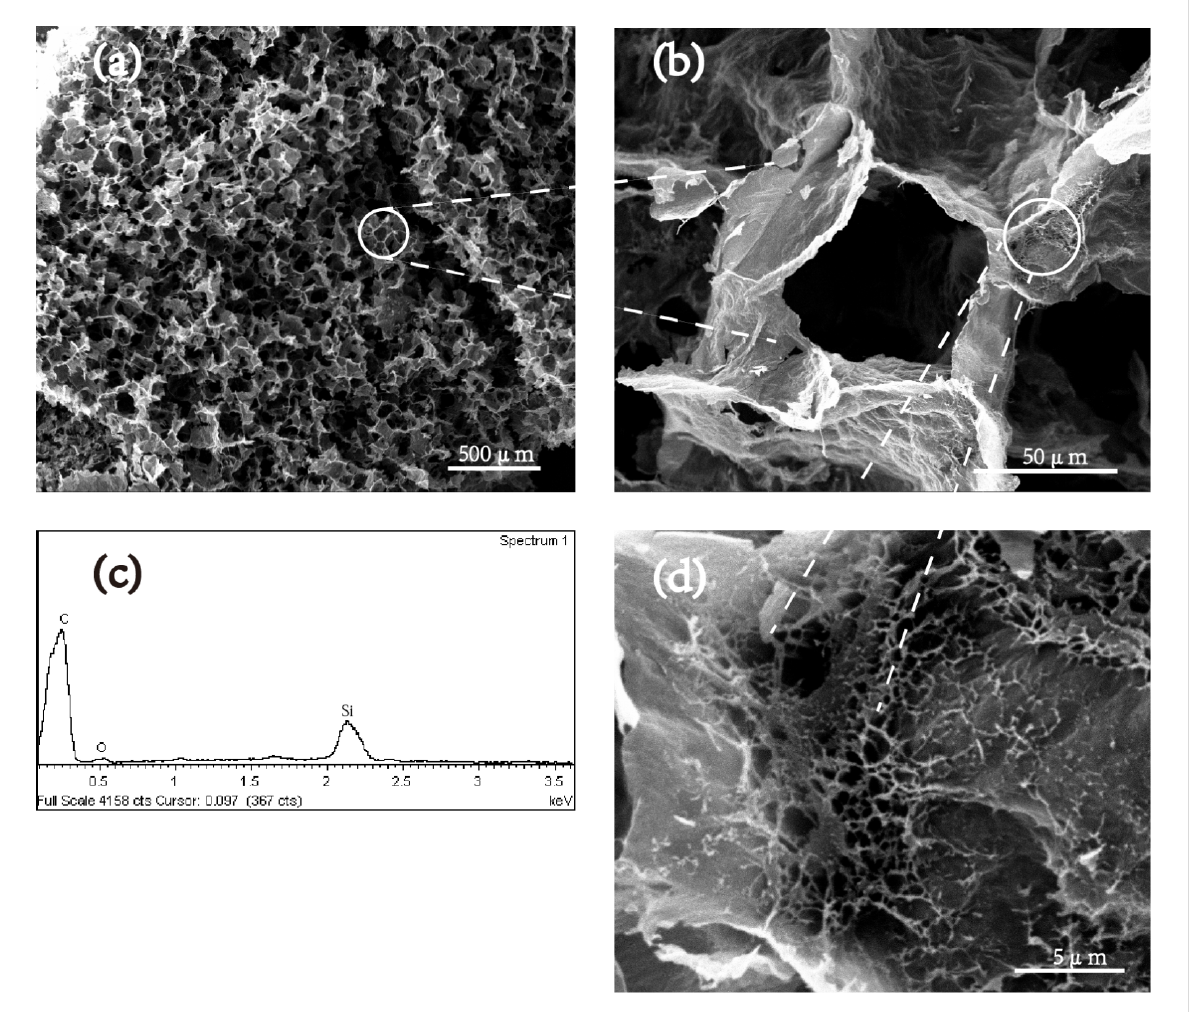
Figure 2: (a), (b), and (d) are SEM images of the inner part of the super-hydrophobic CNF/PVA/GO carbon aerogel; (c) EDS element mapping of the CNF/PVA/GO carbon